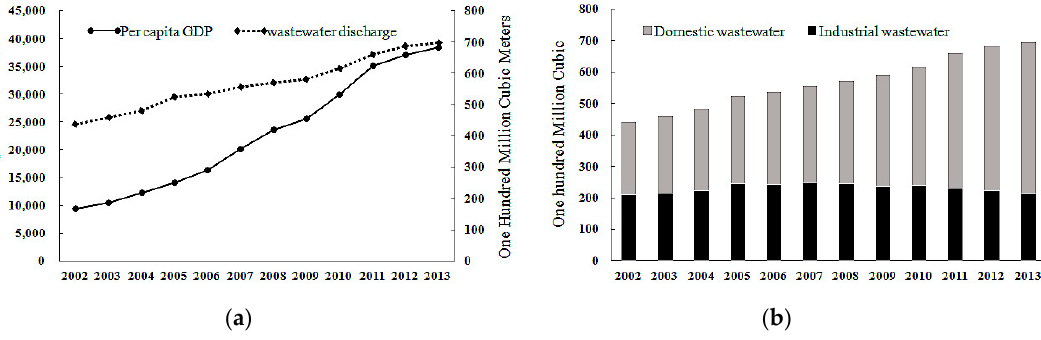
Figure 1. Wastewater discharge and the change of per capita GDP in China, 2002–2013. (( a ) represents the per capita GDP and total wastewater discharge of China from 2002 to 2013, while ( b ) represents domestic and industrial wastewater discharge of China from 2002 to